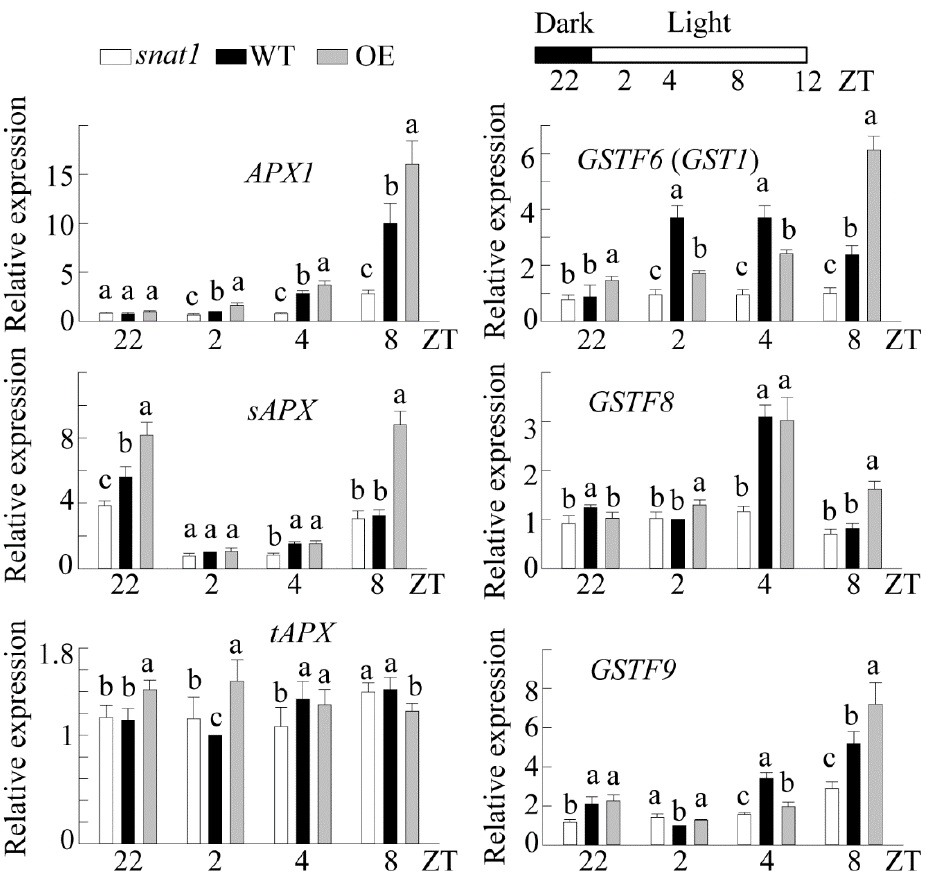
Figure 5. Temporal qRT-PCR analysis of various Arabidopsis genes involved in the reactive oxygen species (ROS) defense and scavenging systems at various ZT intervals. Total RNA was isolated, and transcript levels in WT, snat1 , and OE Arabidopsis lines were measured by qRT-PCR. The relative fold expression values are normalized to EF1 α expression. Error bars show the standard deviation of three biological replicates. Different letters indicate significant differences (Tukey’s post hoc HSD test; p < 0.05).